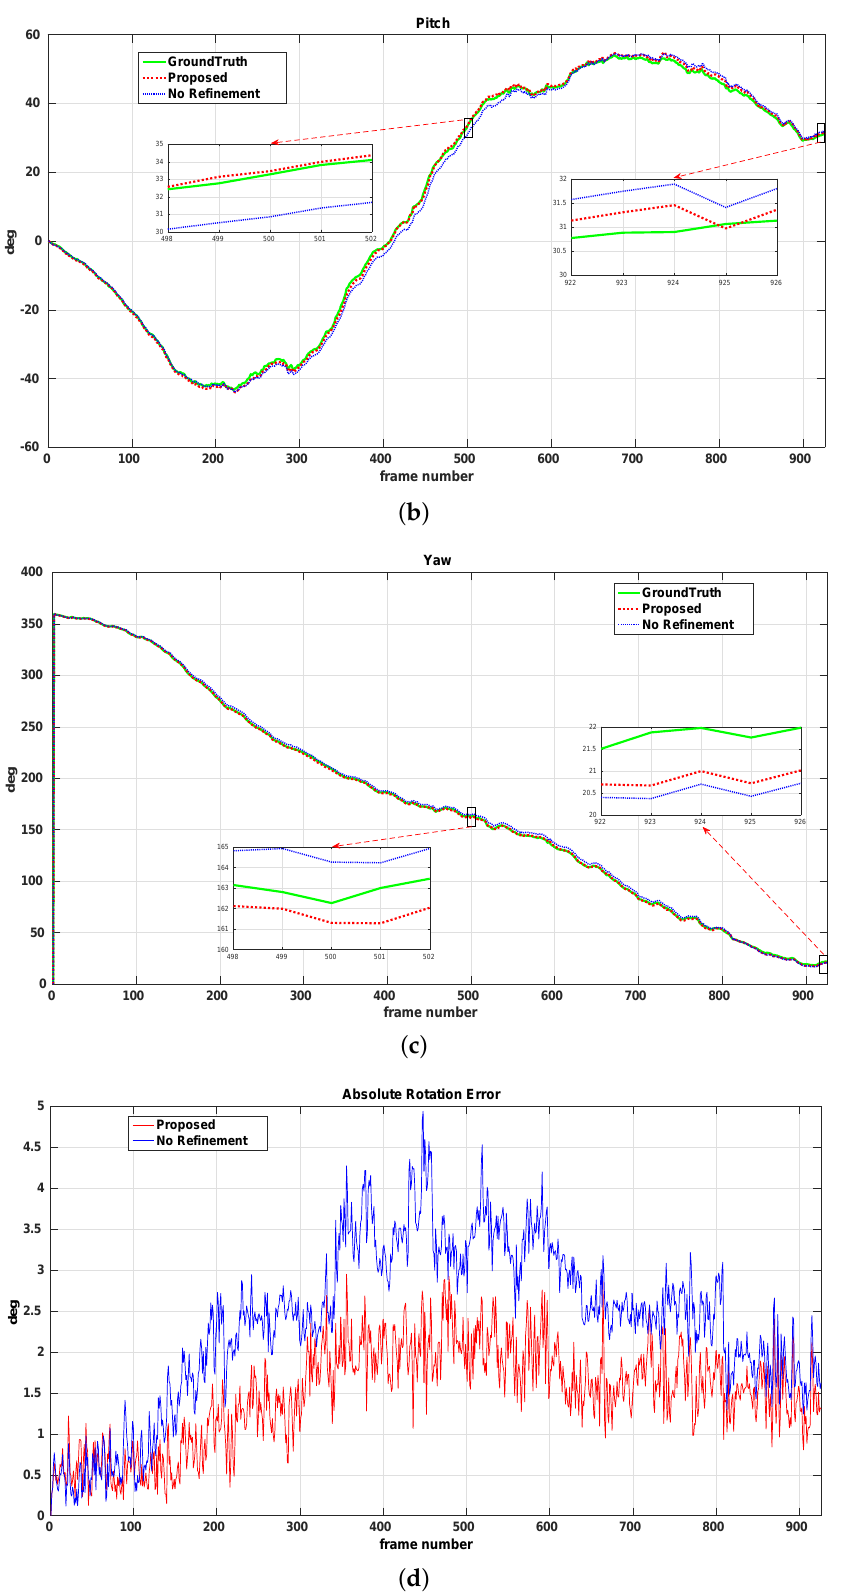
Figure 9. Performance evaluation for refinement on the ‘fr3_cabinet’ sequence: ( a – c ) Roll, pitch, and yaw angles estimated by our proposed method with and without a refinement step for each frame. ( d ) Absolute rotation errors for the proposed methods with and with refinement step. This shows that the refinement step can effectively reduce rotation